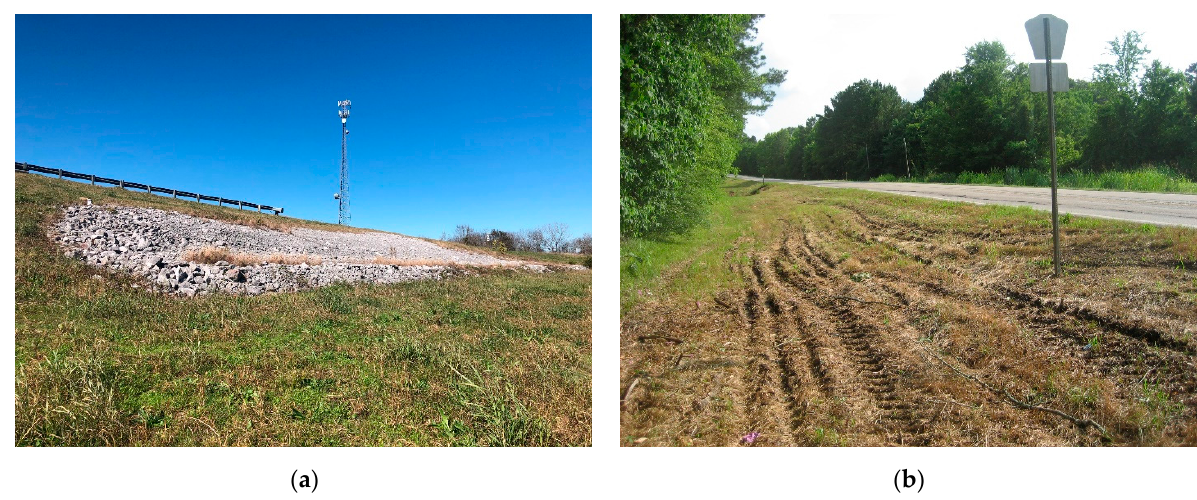
Figure 2. Photos of: ( a ) a repaired slope failure in an embankment section of AL-5 in Perry County approximately five miles south of the project site; ( b ) a shallow slope movement leading to cracking in the travel lane and bulging at the toe of the embankment (as highlighted by the mower tracks).